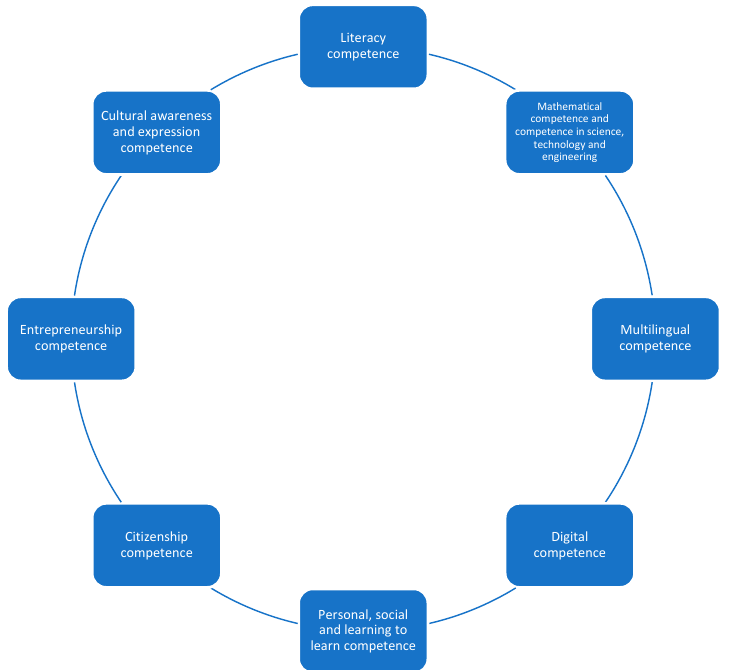
Figure 1. Professional competence model. Source: European Commission /EACEA/Eurydice (2018).